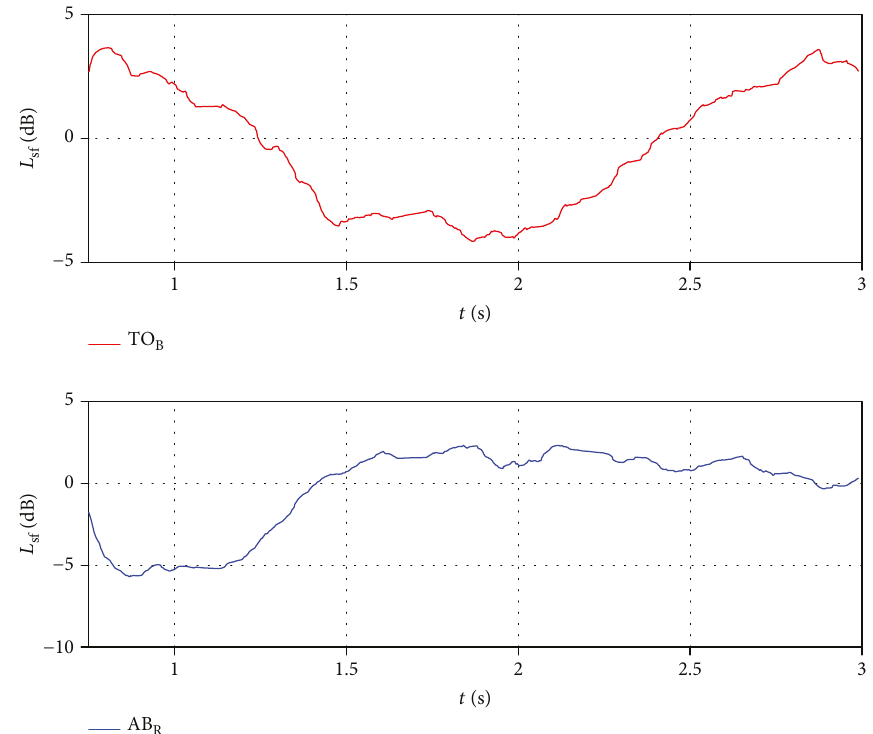
Figure 6: Exemplary graph of the slow fading component in a single realization of scenario for C7.